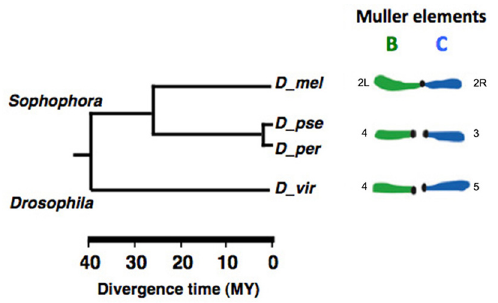
Fig 2. Phylogenetic relationships among syntenic chromosomes of the analysed Drosophila species. The scheme shows the phylogenetic relationships between D . melanogaster , D . pseudoobscura , its sibling species D . persimilis and D . virilis , as defined by Muller [45]. The syntenic Muller elements (right) are shown by the number of their corresponding